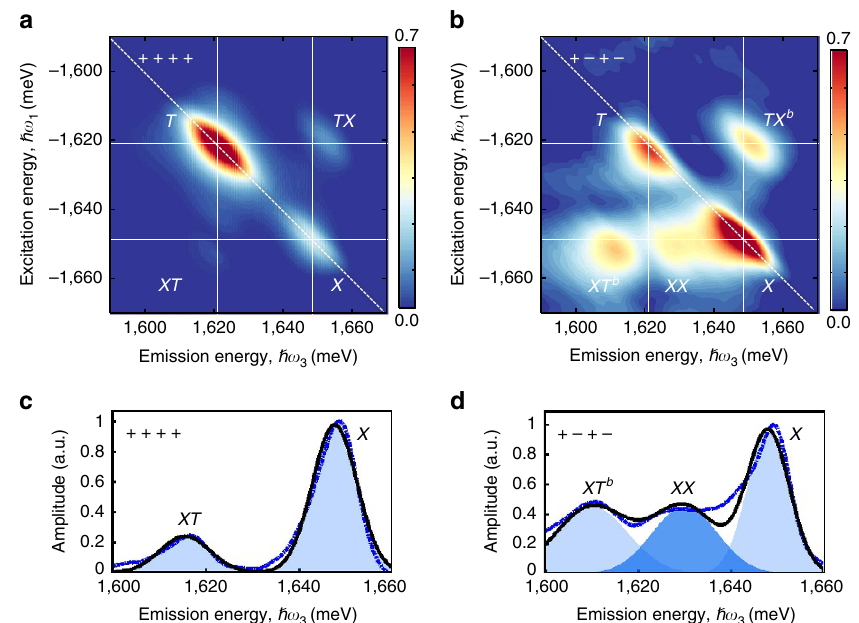
Figure 3 | Measured polarization-resolved 2D coherent spectra revealing the biexciton resonances. ( a ) Normalized 2D amplitude spectrum obtained using co-circular polarization of the excitation pulses and detected four-wave mixing signal. The spectrum features two diagonal peaks corresponding to the degenerate excitation and emission of the exciton ( X ) and trion ( T ) resonances and two off-diagonal peaks ( XT and TX ) corresponding to their coupling. ( b ) Normalized 2D amplitude spectrum obtained using cross-circular polarization of the first/third fields ( s þ ) and second/signal fields ( s (cid:2) ). The additional peak ( XX ) is associated with the neutral bound biexciton, while the shift of the off-diagonal peaks TX b and XT b Þ (cid:2) to lower emission energy is associated with the charged bound biexciton. Slices along the emission energy axis ( B 50 m eV resolution) at an excitation energy of 1,648 ± 0.05meV are shown in ( c , d ) for co-circular and cross-circular polarization, respectively. The data are fit with double and triple Gaussian functions (solid lines), respectively, with the individual fits to peaks XT b , XX and X indicated by the shaded regions.